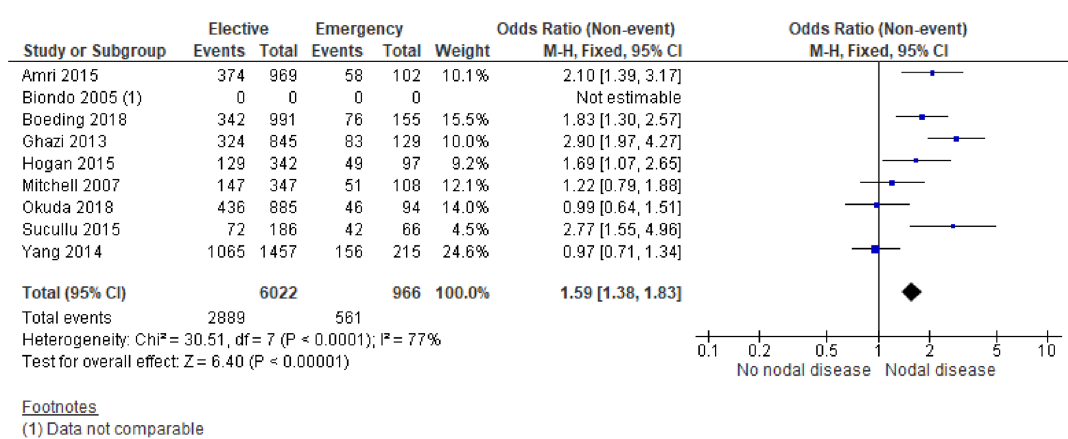
Figure 5. Association between T Stage and emergency presentation—Forest Plot.